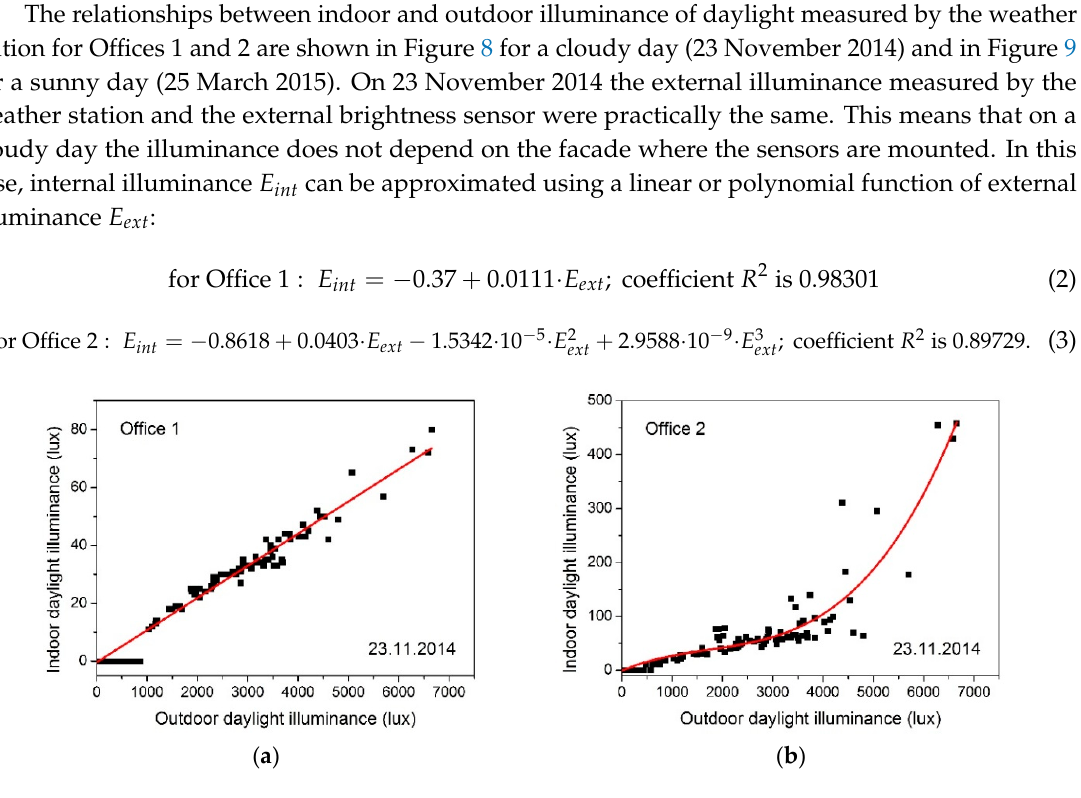
Figure 8. Relationships between internal and external illuminance of daylight measured by weather station on cloudy day on 23 November 2014 for ( a ) Office 1 and ( b ) Office 2.